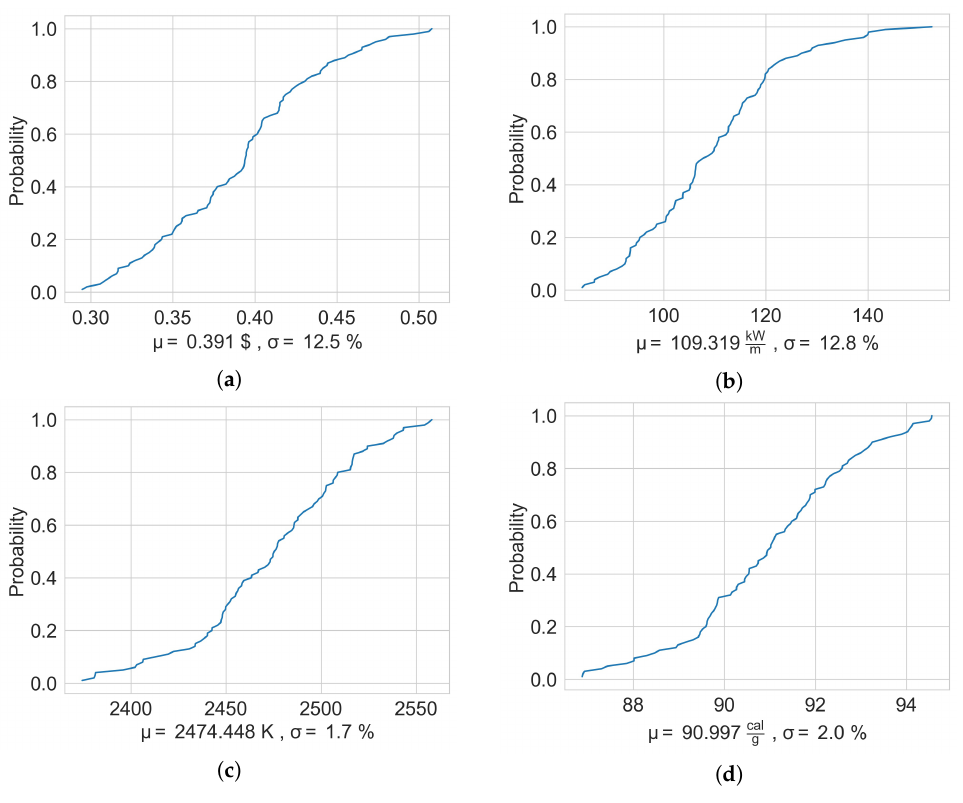
Figure 21. ECDF of ( a ) ρ in , ( b ) P max